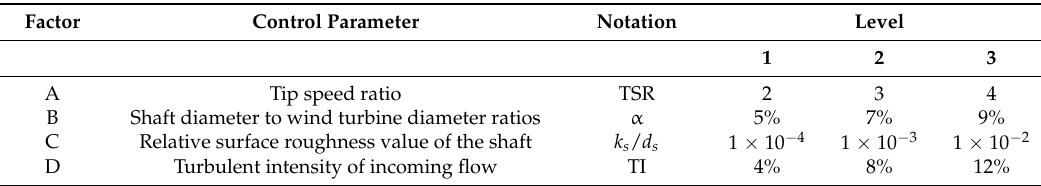
Table 5. Factors, control parameter, and levels.